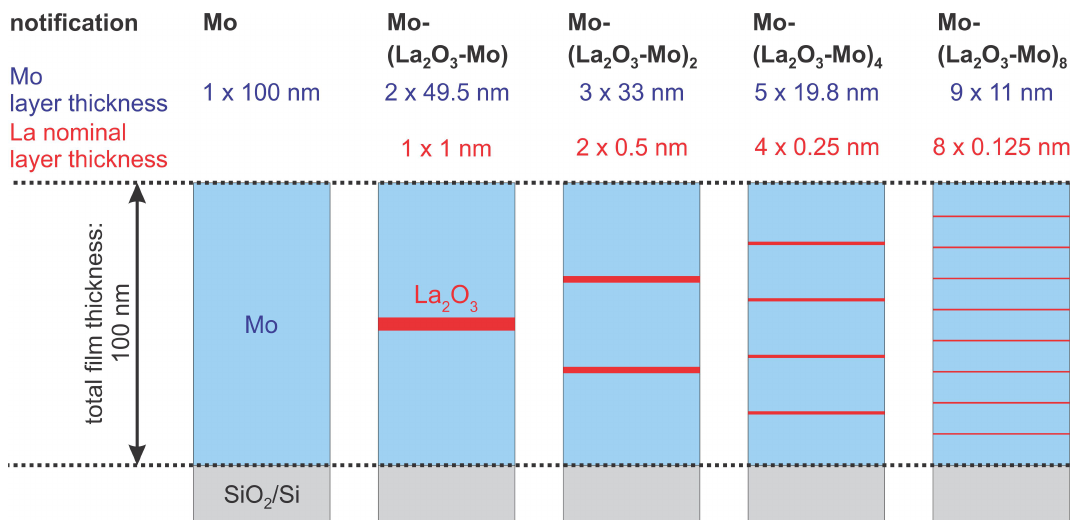
Figure 1. Sketch of the various types of samples with a different number n of La 2 O 3 interlayers. For the multilayers the La nominal layer thickness is the thickness theoretically reached after 1 / n of the deposition time necessary to deposit 1 nm of La. The Mo layer thickness is reached after 1 / ( n + 1 ) of the time necessary to deposit 99 nm of